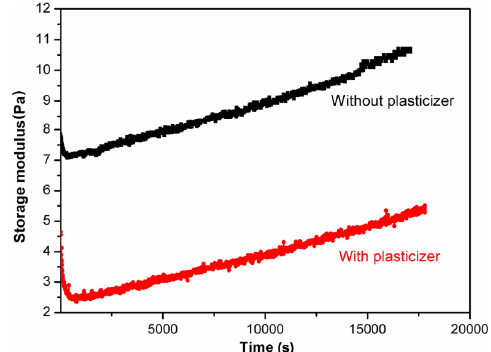
Fig. 5 Effect of plasticizer on the evolution of storage modulus G ′ of slurries with a solids loading of 40 vol%.